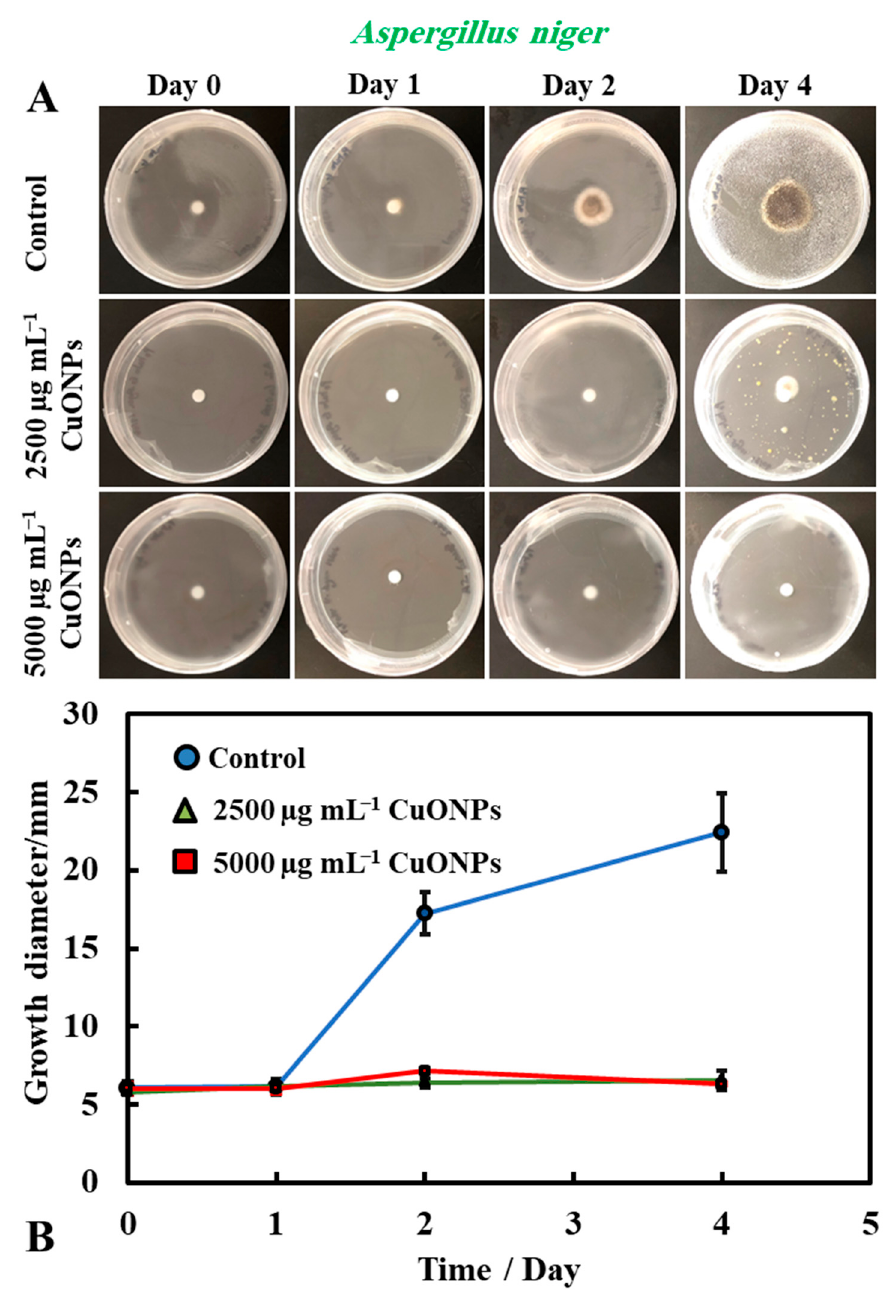
Figure 3. ( A ) Digital photographs of the PDA–gel plates containing A. niger seeded in the center and with bare CuONPs as an antimould agent at testing concentration of 2500 and 5000 µ g mL − 1 , respectively, applied on the top of the PDA medium, and monitored over a period of four days, in an incubator, at 25 ◦ C. ( B ) Growth diameter of a circular spot of A. niger seeded on paper disc is presented as a function of time, comparing the antimould effect of the CuONPs. The solid lines are guides to the eye.